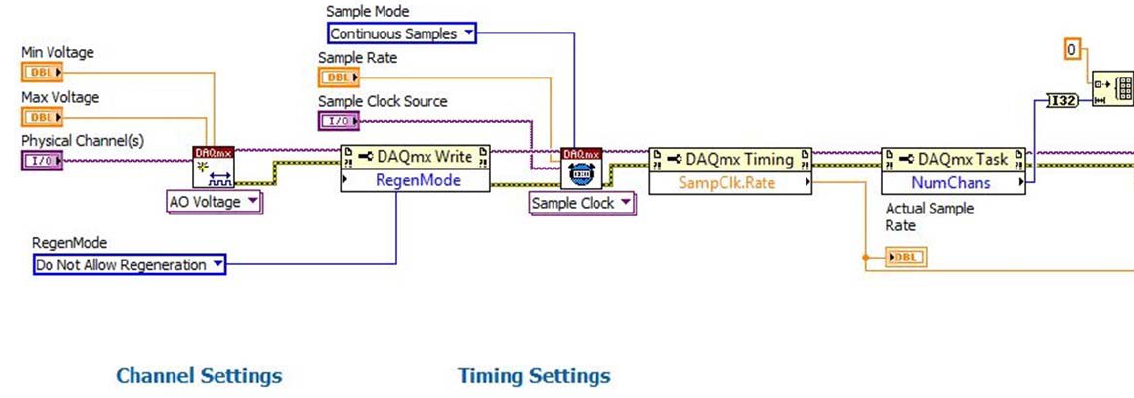
Figure 4. The first part of the block diagram panel.